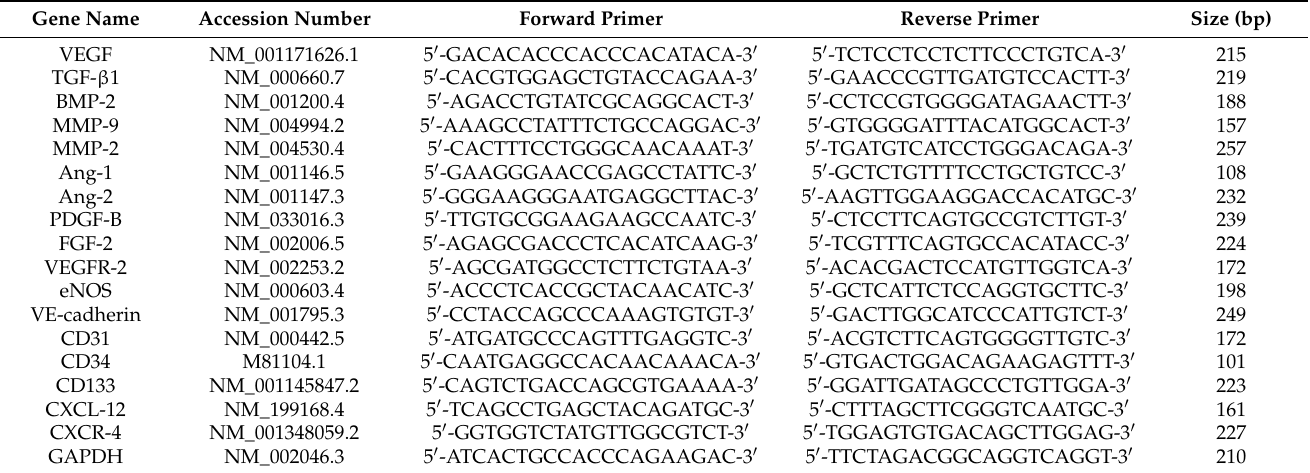
Table 1. Oligonucleotides used for quantitative real-time PCR